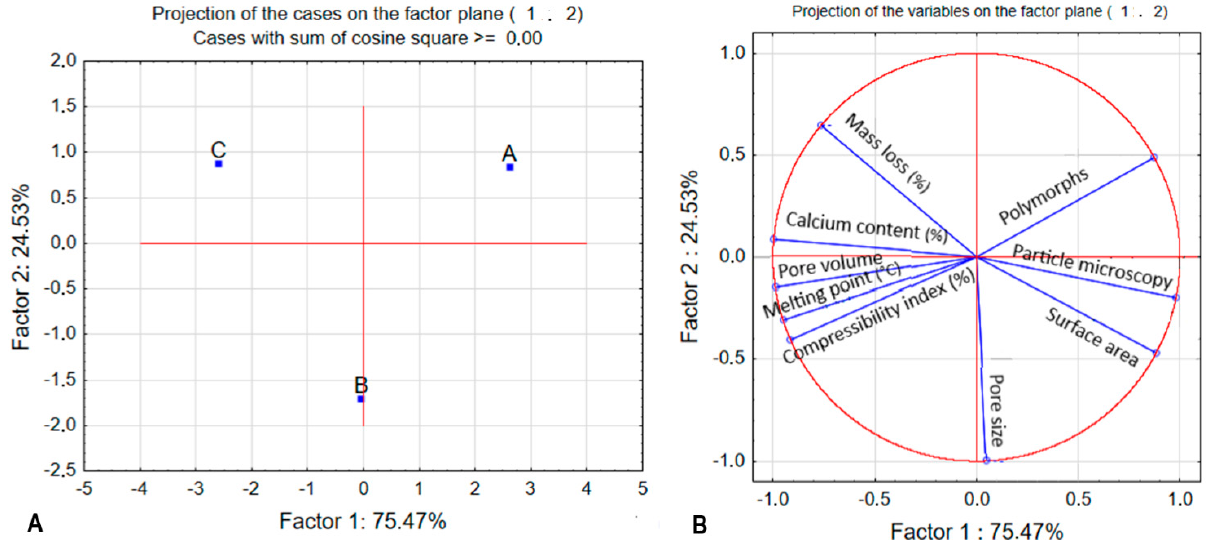
Figure 7. Main component graphs: ( A ) sample distribution of L. calcareum CaCO 3 (A), inorganic mineral CaCO 3 (B) and oyster shell CaCO 3 (C) according to trends observed in multivariate analysis; ( B ) two ‐ dimensional graph of main components. Both factors 1 and 2 correspond to 100% of the information contained in the original variables.